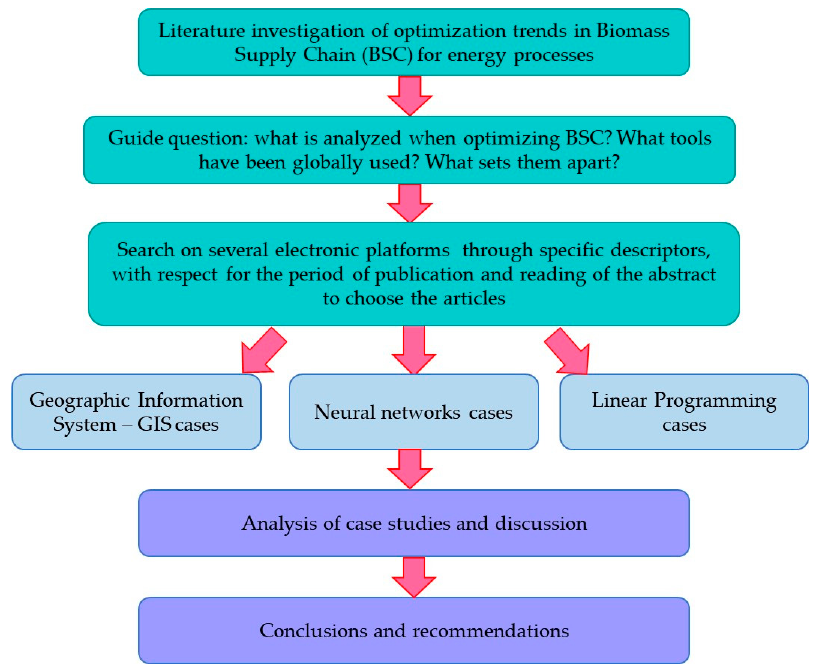
Figure 4. Research methodology.